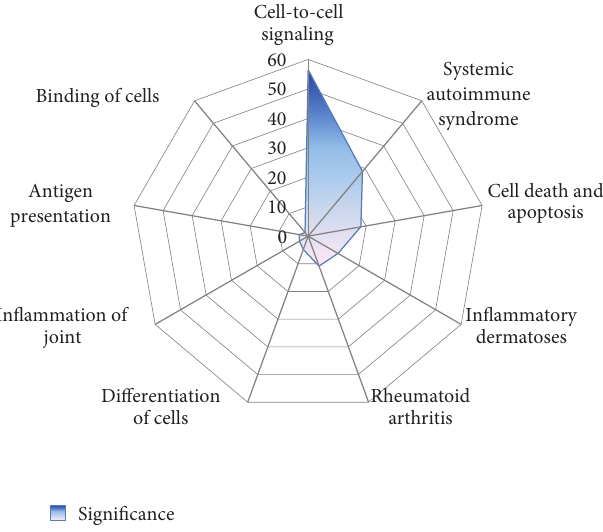
Figure 2: Biological functions corresponding to the shared